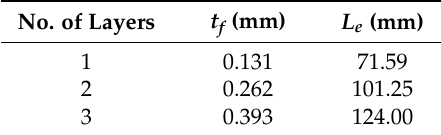
Table 2. Effective bond length for different number of